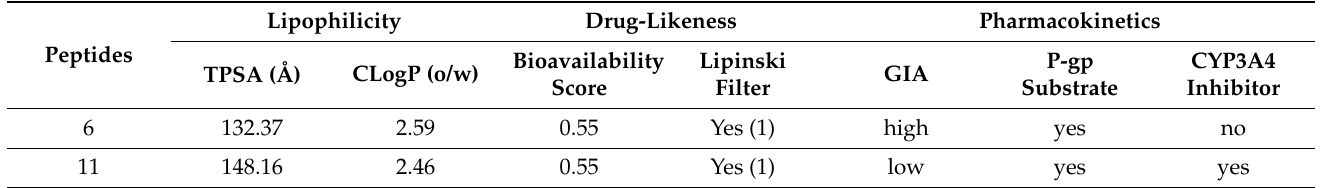
Table 4. in silico ADME study for peptides 6 and 11